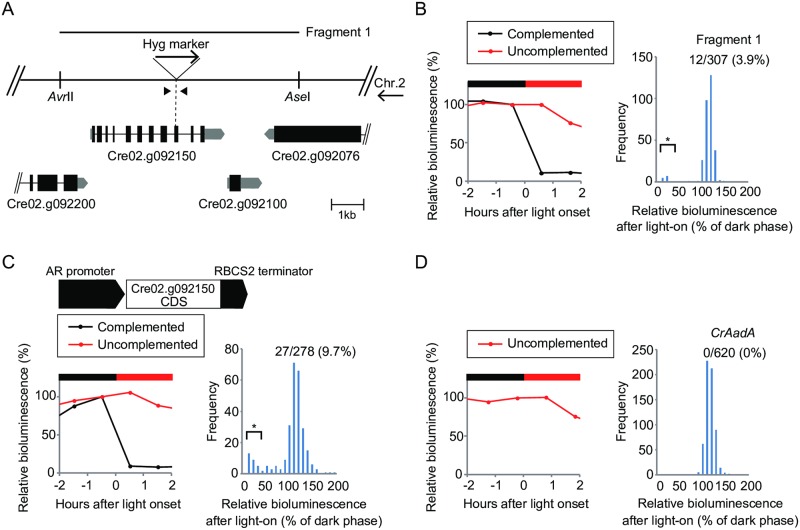
Identification of the disrupted gene in b16.(A) Schematic representation of genomic region around the insertion site (shown in reverse orientation of the sequence for chromosome 2). The specific primers bracketing the insertion site are shown as arrowheads. (B–D), Complementation of the b16 phenotype. b16 mutant was transformed with a gDNA fragment (B, Fragment 1) and cDNA of the Cre02.g092150 gene (C). The left panels show ROC15-LUC bioluminescence of representative transformants monitored under the same conditions as Fig 1. Data before and after the light onset of the first DL cycle are shown. The bioluminescence level just before light onset was set to 100. The right panels are histograms representing the distribution of bioluminescence levels of all transformants after light on (relative to the dark phase). Asterisks indicate complemented transformants (the relative bioluminescence level after light on < 30). Numbers of complemented transformants and the rate of complementation are indicated in the graphs. A negative control experiment where b16 mutant cells were transformed by CrAadA marker only is shown (D).